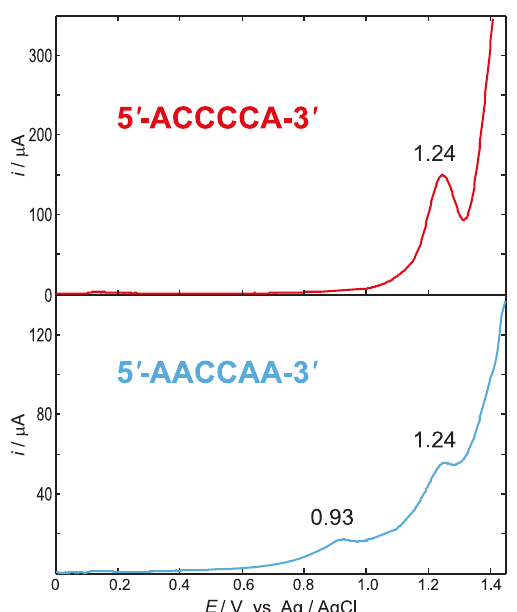
Figure 6. Differential pulse voltammetry of 2.0 mM single stranded 5 (cid:48) -ACCCCA-3 (cid:48) (top, red) and 0.50 mM 5 (cid:48) -AACCAA-3 (cid:48) (bottom, blue) in 50 mM phosphate buffer solution. Internal reference electrode Ag/AgCl (3.0 M KCl). A lowering of the first anodic signal amounting to 0.31 V is observed in passing from the sequence not containing stacked adenines to the one holding two stacked A’s. Adapted with permission from J. Phys. Chem. B 2013 , 117 , 8947–8953. Copyright (2013) American Chemical Society.